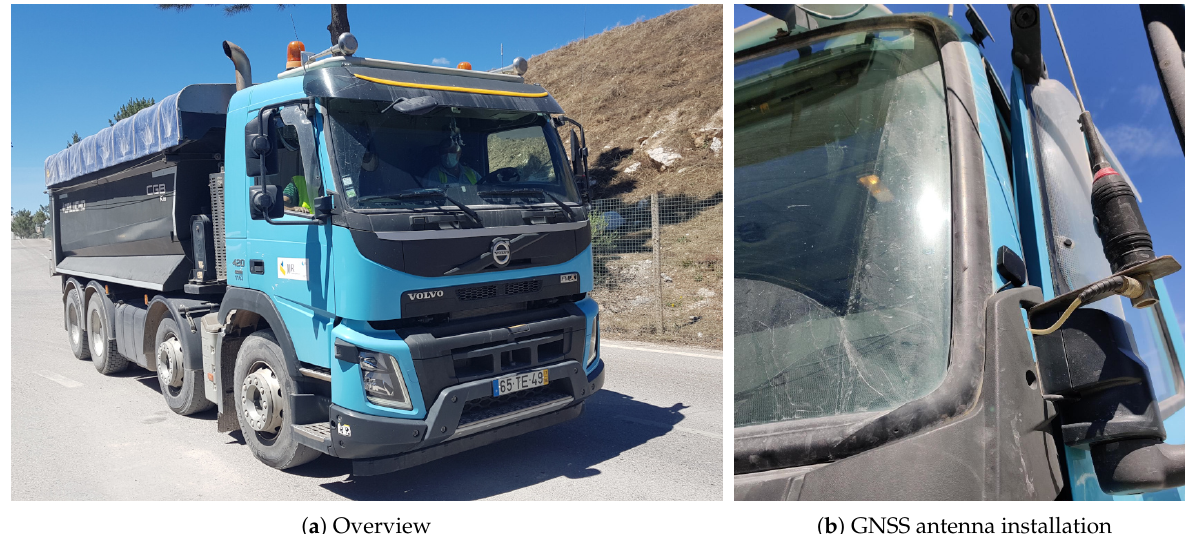
Figure 5. Volvo truck used in the field